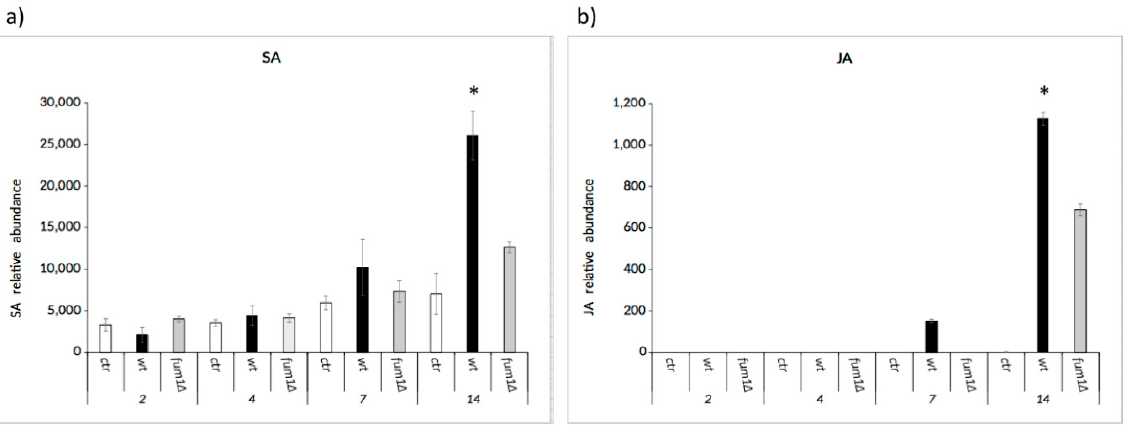
Figure 6. HPLC-MS/MS quantification of hormones. SA ( a ) and JA ( b ) in seedling infected by F. verticillioides wild-type (wt) or fum1 ∆ strains compared to seedling not infected (ctr). Data represent the means ± standard error of three technical replicates. Asterisks above the bars indicate a significant difference between the ctr and wt or fum1 ∆ infected seedlings at the same time point (Student’s t -test, * p < 0.05).